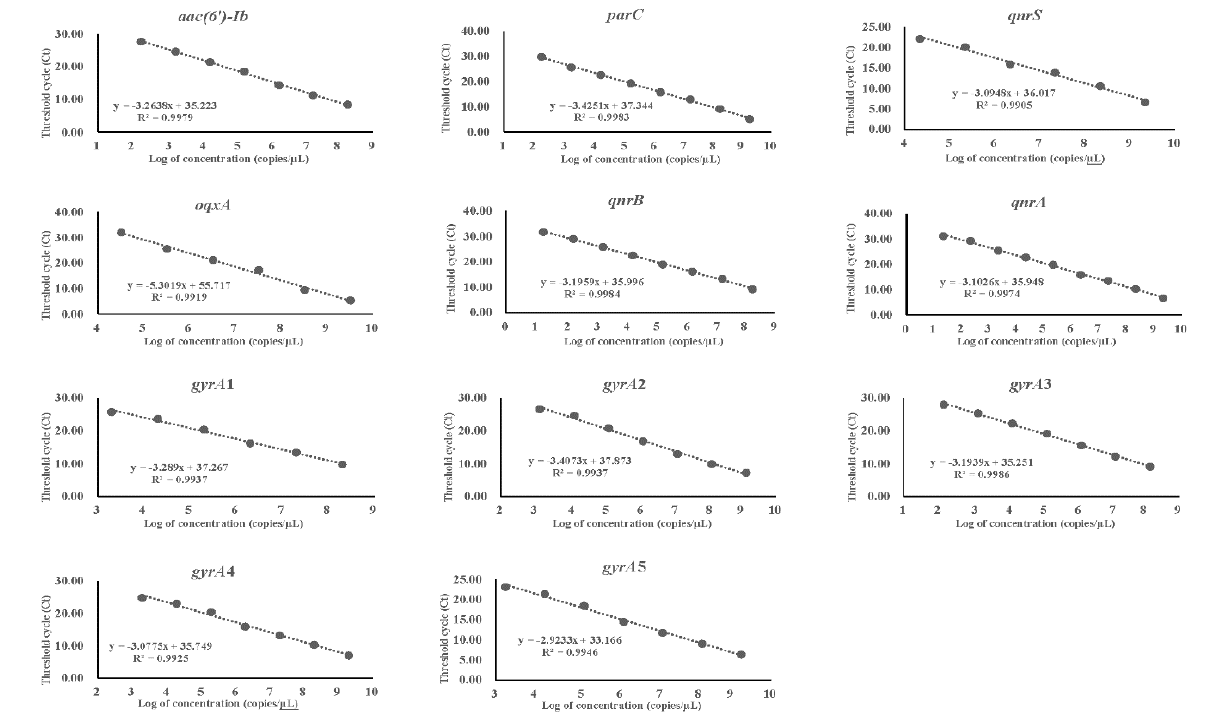
Figure 4. Standard curve and Ct values of qPCR for each target DNA. X axis represents logarithm of concentration, and Y axis represents Ct values for different concentrations of template DNA.